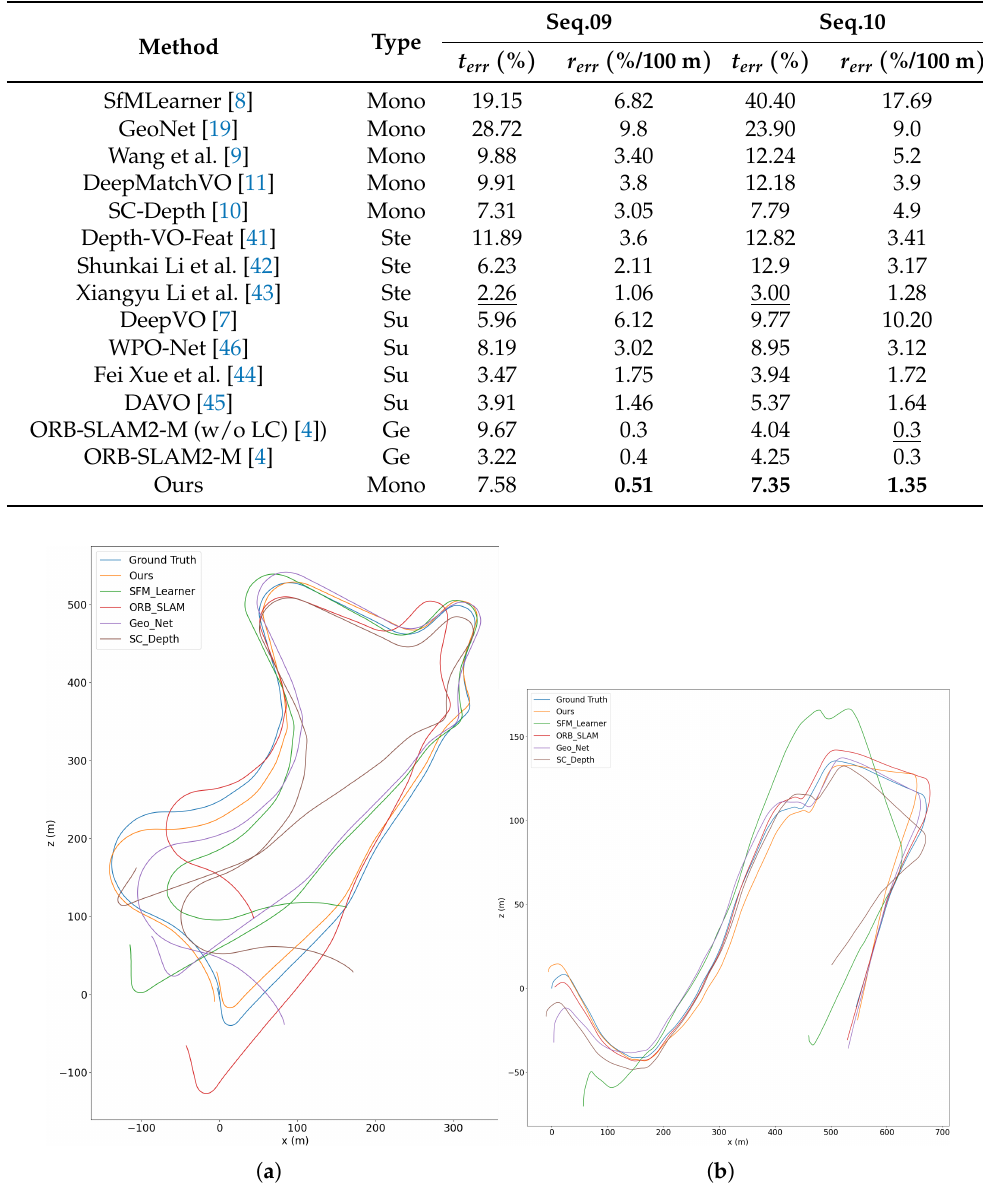
Figure 5. Trajectory results of different methods in sequence 09 ( a ) and sequence 10 ( b ) of KITTI dataset. Our method is much closer to the ground